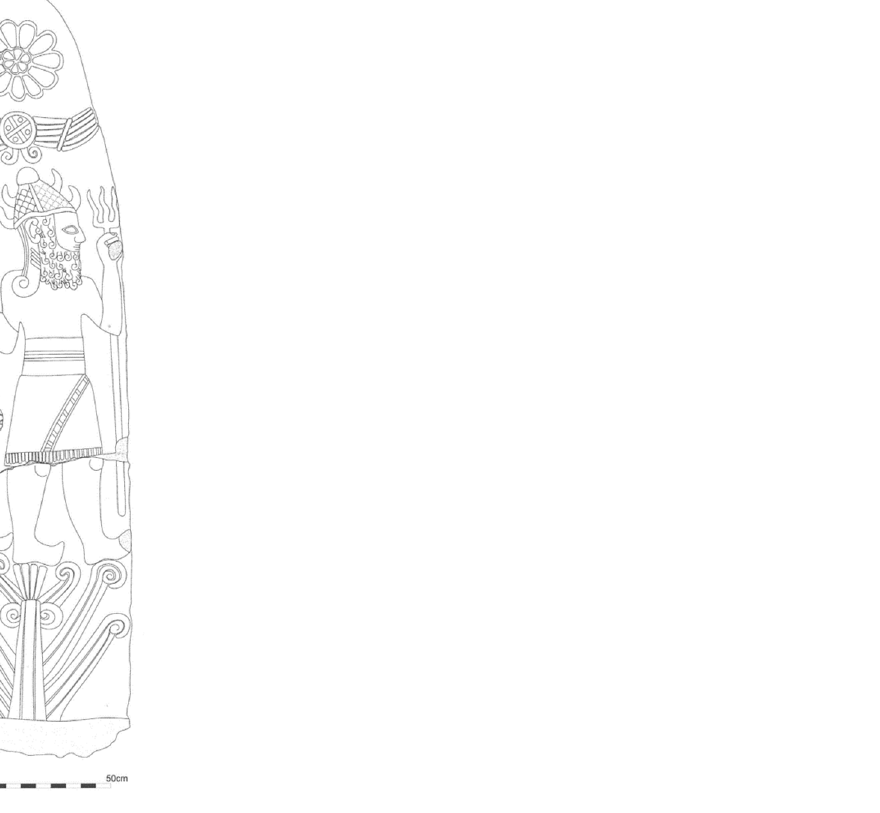
Figure 6. Drawing of the ARSUZ 1 stela (from Dinçol et al. 2015, Fig. 06).